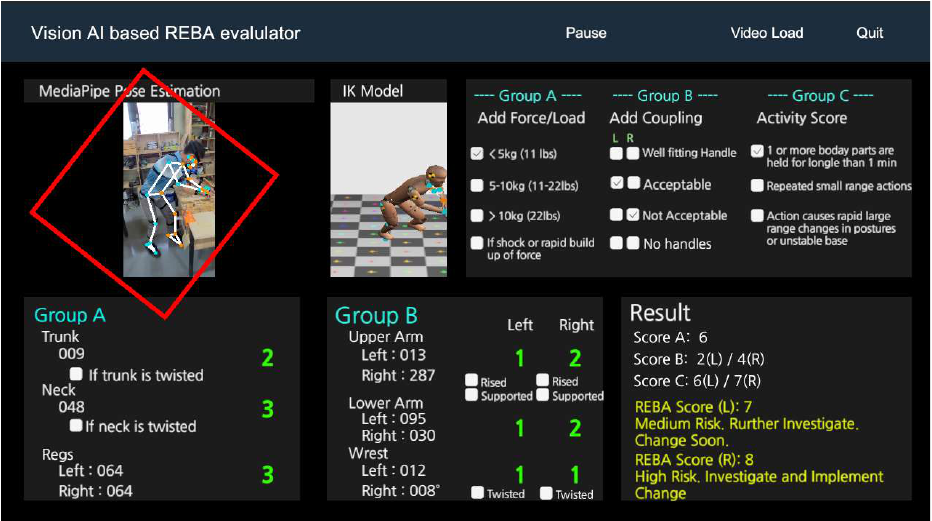
Figure 33. Evaluation of planer working posture.